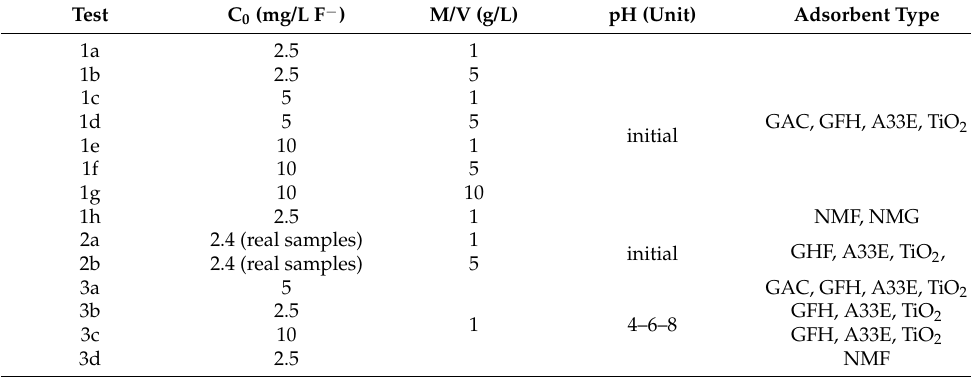
Table 2 lists the main operating conditions of all the series of adsorption kinetic tests. Table 2. Main operating conditions of kinetic